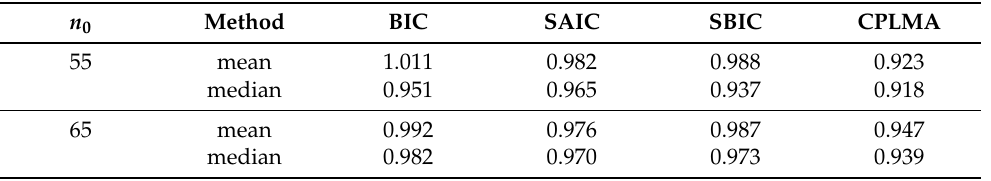
Table 4. The mean and median of RMSPE across 1000